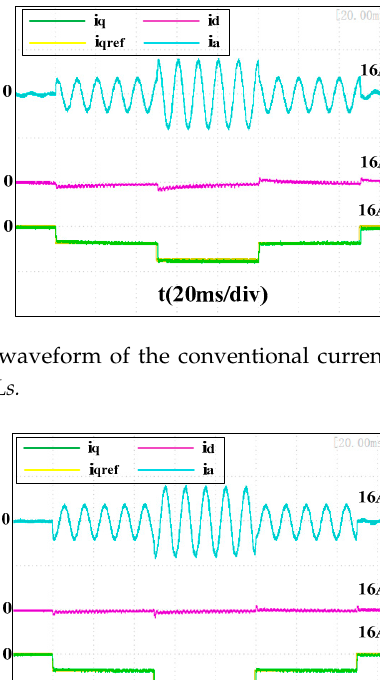
Figure 14. d-q axis current waveform of the conventional current controller without decoupling at 6000 rpm with Kp = 1000 π Ls.